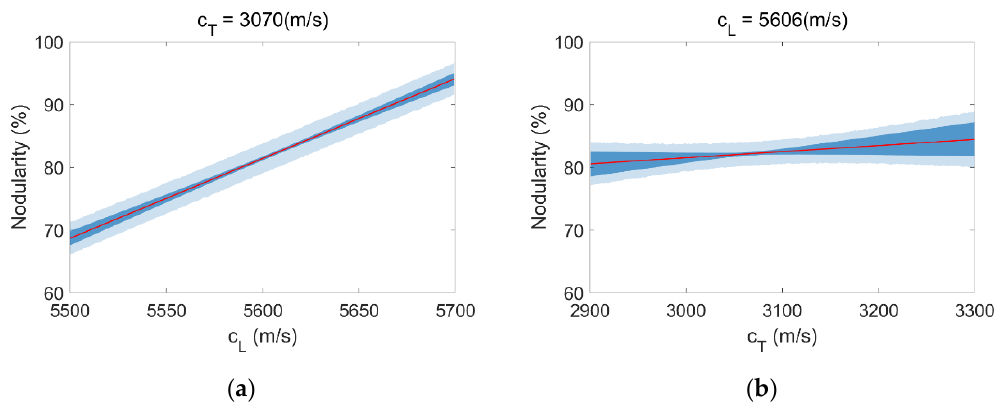
Figure 11. (Color Online) The regression function and its associated 90% confidence bounds of tra- ditional Bayesian regression model from the thirteenth week. ( a ) a cross-section at c T = 3070 m/s, ( b ) a cross-section at c L = 5606 m/s.